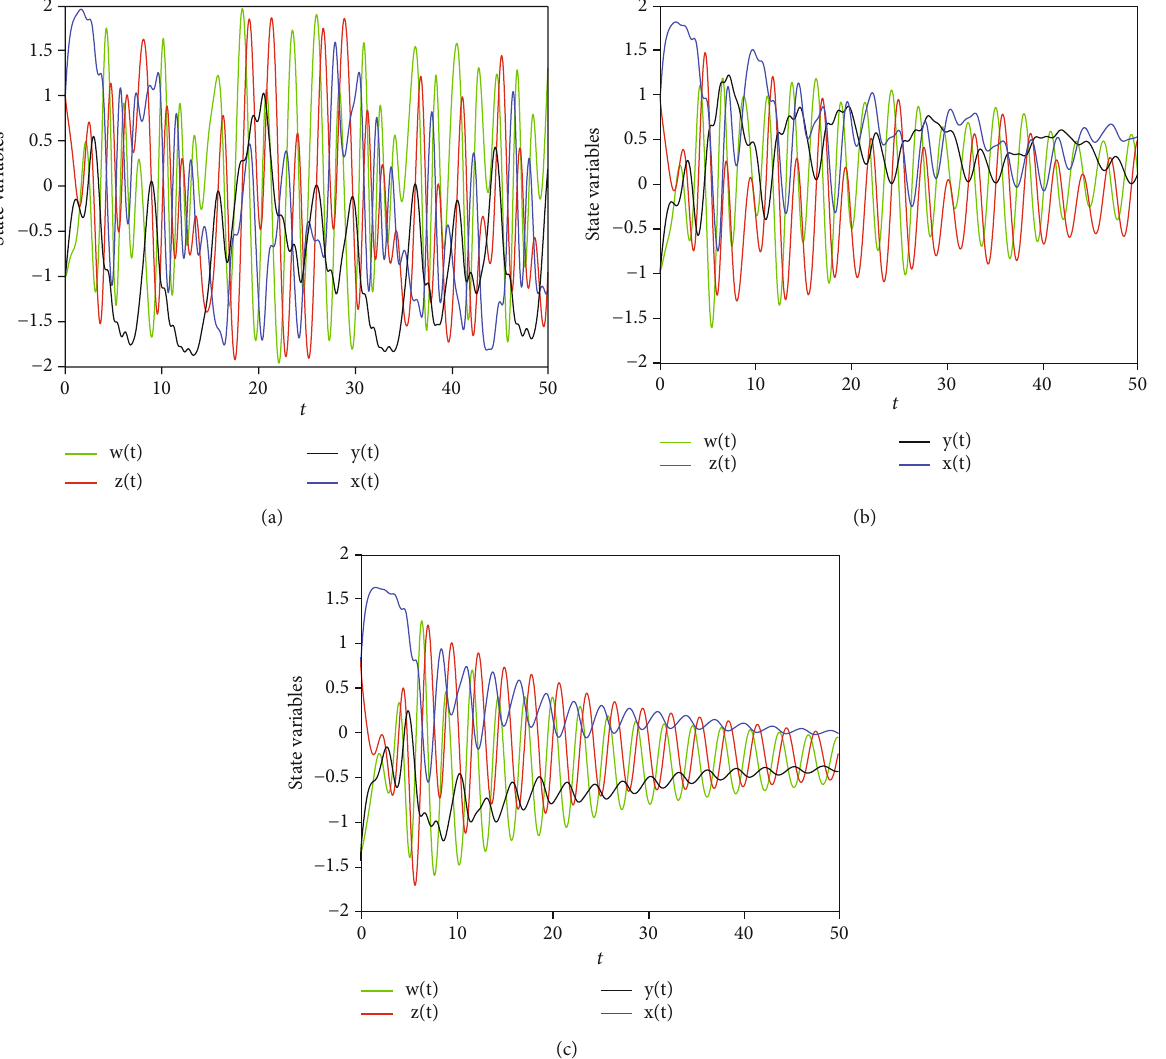
Figure 18: The behavior of di ff erent state variables of system 2 vs. time t with fractional order ϖ = 0 : 98 and the parameters n = m = 2